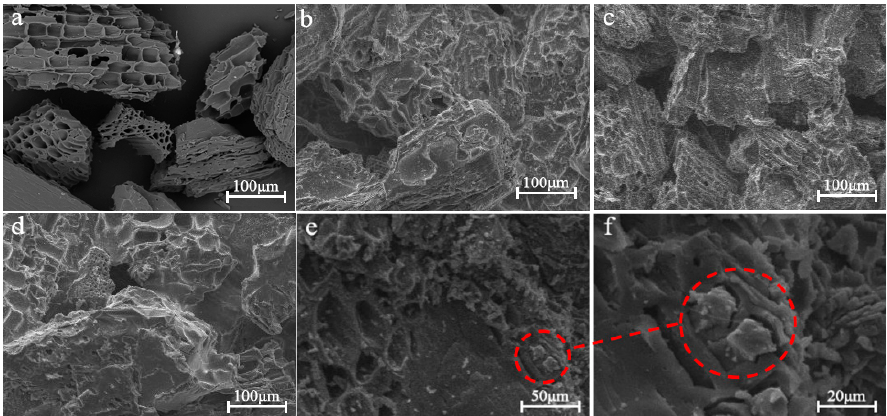
Figure 3. Micro-structures of the BC/SS composites with the mass ratios of ( a ) 10:0 (pure BC), ( b ) 10:3, ( c ) 10:4, ( d ) 10:5, and ( e and f ) its high-magnification images.